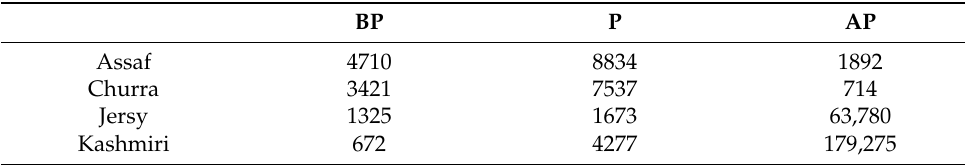
Table 4. The number of breed-stage-specific SNPs in milk QTL